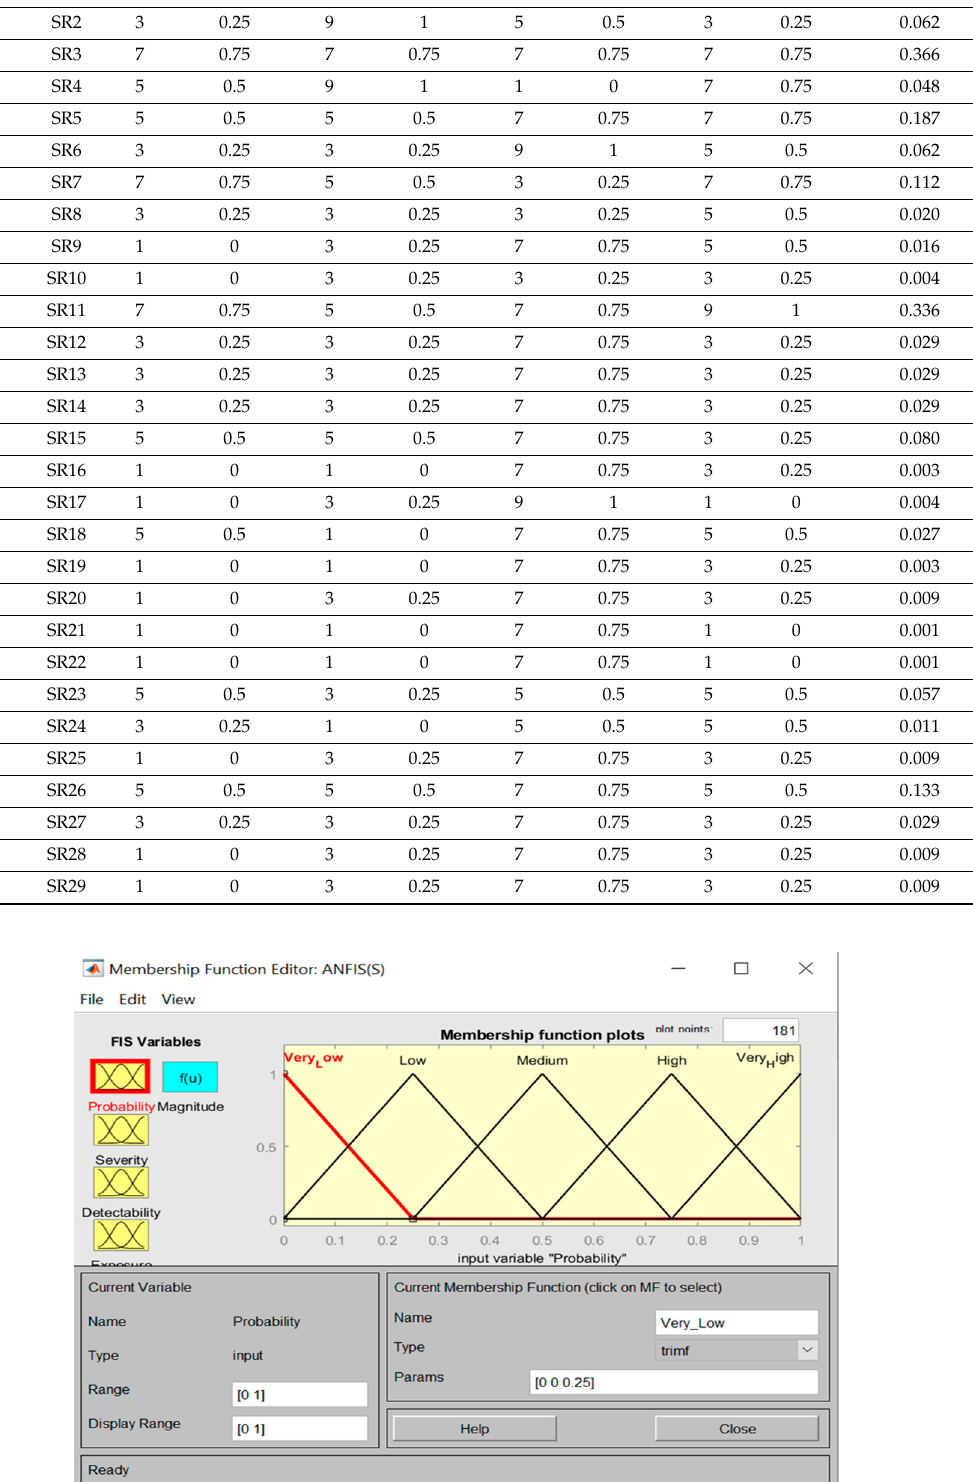
Figure 7. Triangular membership functions with membership values between 0–1.